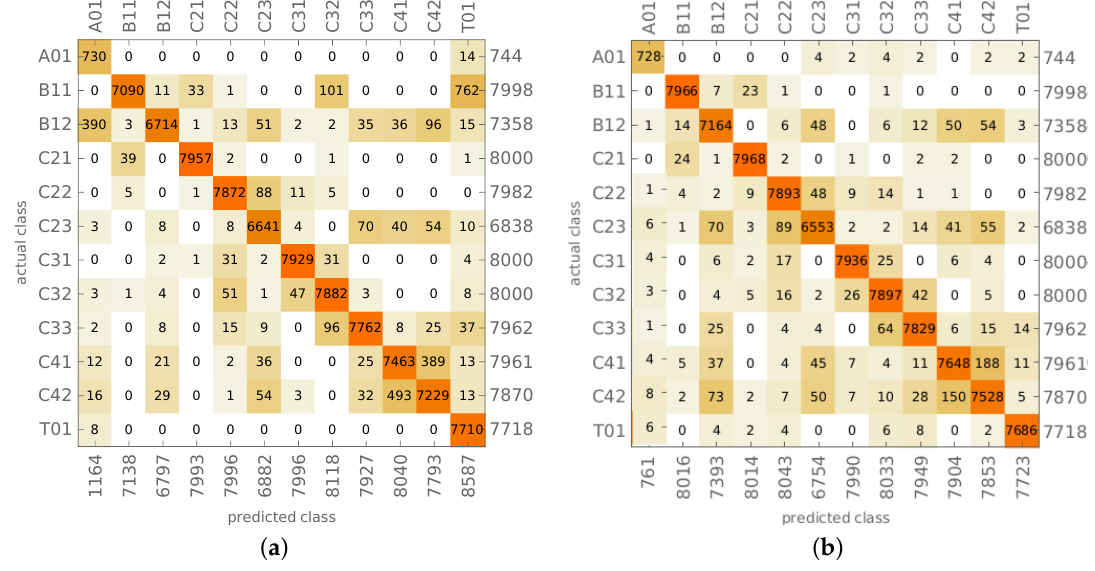
Figure 9. Identification of mode shapes obtained from models with material degradation using: ( a ) CNN- O learned on mode shapes obtained from models without material degradation (see Figure 5), ( b ) CNN- D learned using patterns with and without material degradation. Table 4. The results of identification of mode shapes with and without local material